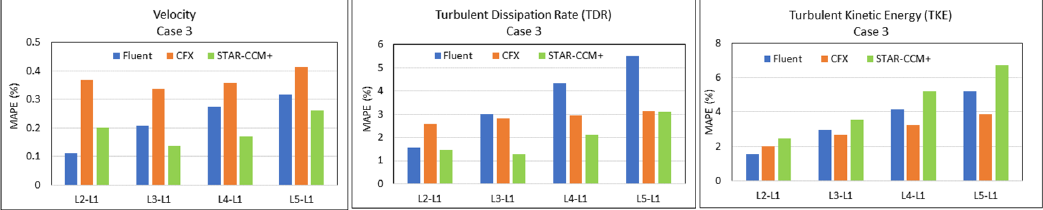
Figure 14. Case 3: Comparison of the mean vertical variations of the absolute percentage errors/differences (MAPEs) for each parameter ( u , TKE, and TDR) using the three software.